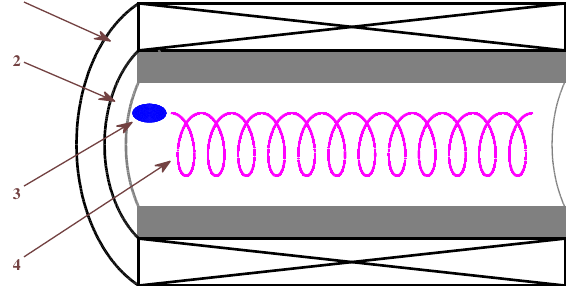
FIG. 1. Scheme of the radiation section: 1 — magnetic system creating a transverse helical undulator and strong uniform longitudinal fields; 2 — oversized metal circular waveguide; 3 — electron bunch; 4 — helical stationary electron